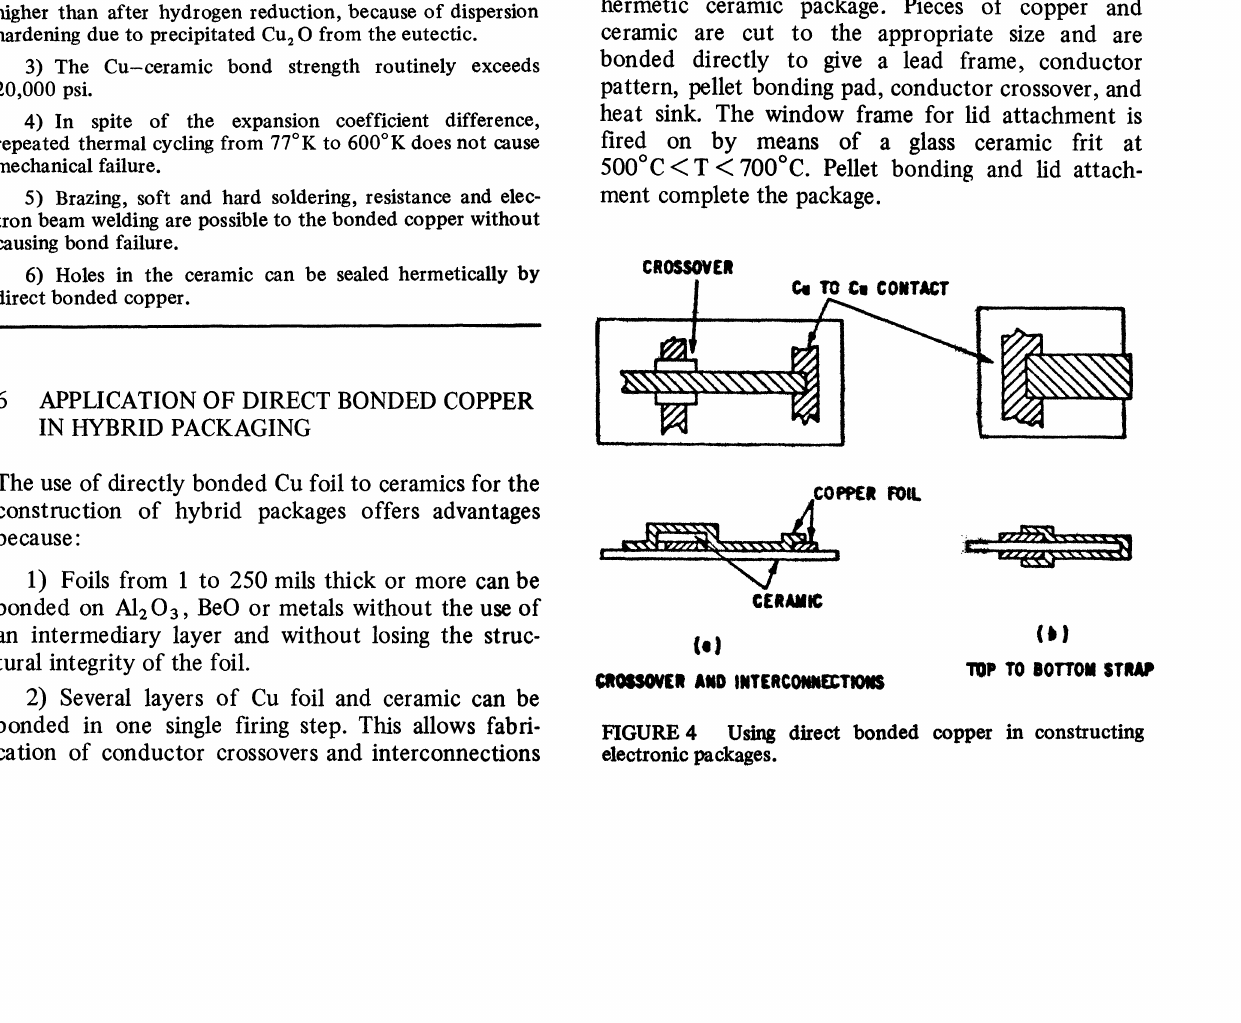
Using direct bonded copper in constructing electronic